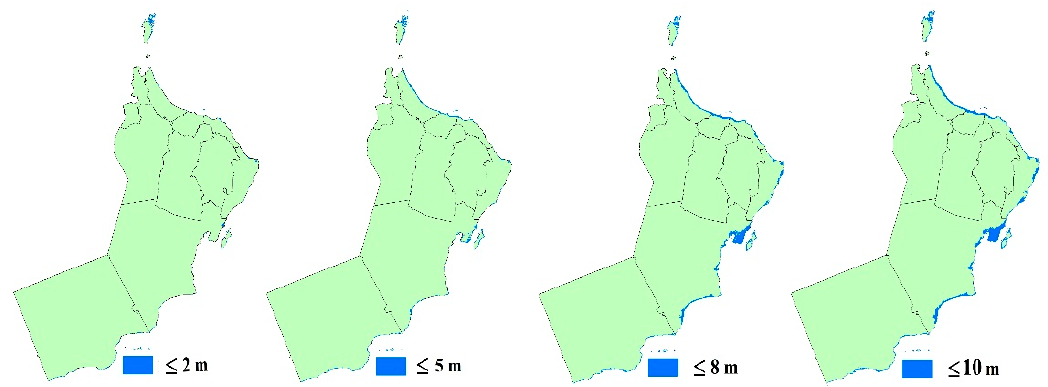
Figure 3. Areas of the elevation levels (1–10 m) and the population of coastal governorates in 2017.